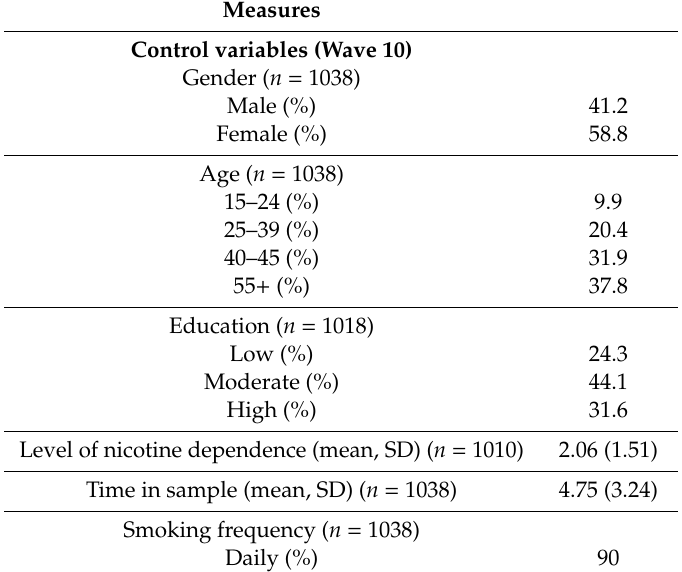
Table 2. Sample characteristics of smokers in Wave 10 who remained in the sample in Wave 11, weighted by gender and